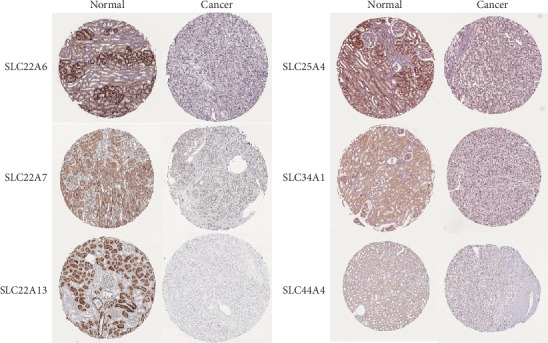
Representative tissue microarray (TMA) slides with SLC22A6, SLC22A7, SLC22A13, SLC25A4, SLC34A1, and SLC44A4 staining. All slides were retrieved from the Human Protein Atlas (HPA, http://www.proteinatlas.org). Magnification, ×100.